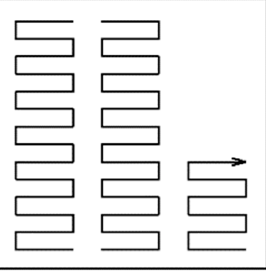
Figure 2. Strip scanning strategy used to build our components by the selective laser melting (SLM) method.